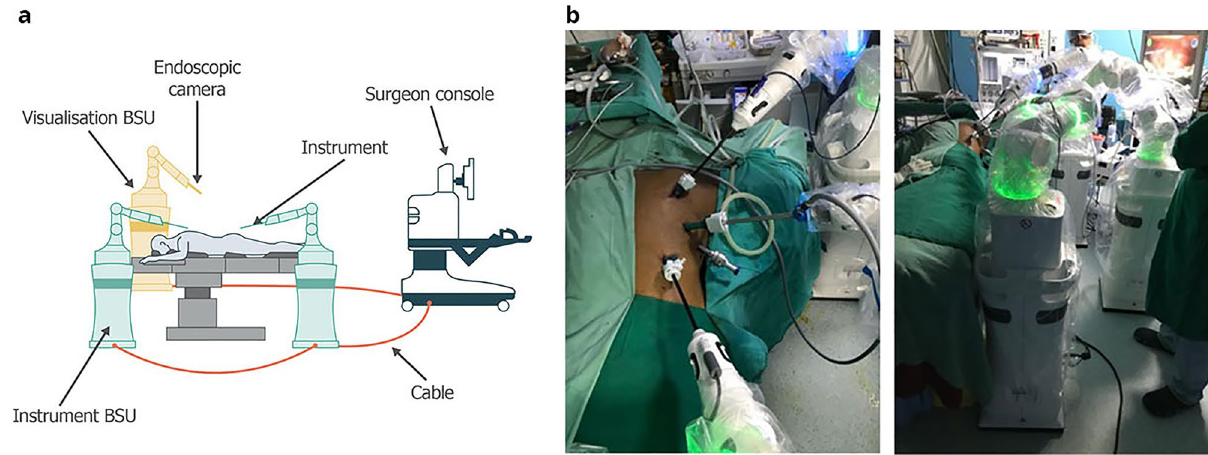
Figure 1. Overview of the Versius Surgical System. Adapted from Haig et al. 17 . Schematic representation of the setup of Versius ( a ) and real-world images of the Versius setup ( b ). BSU: bedside